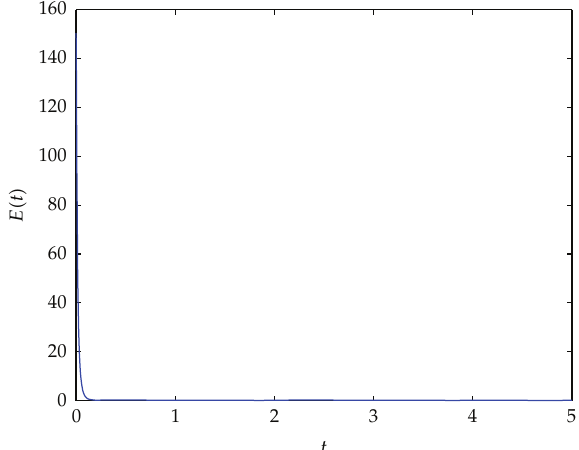
Figure 4: Time evolution of the synchronization error E (cid:6) t (cid:7) .